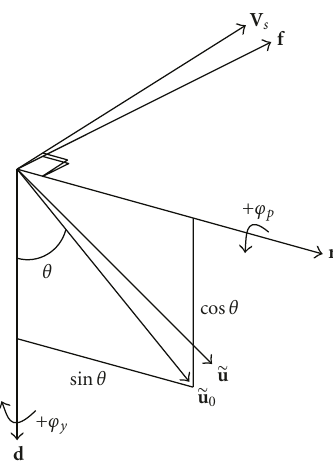
Figure 4: Local reference frame of